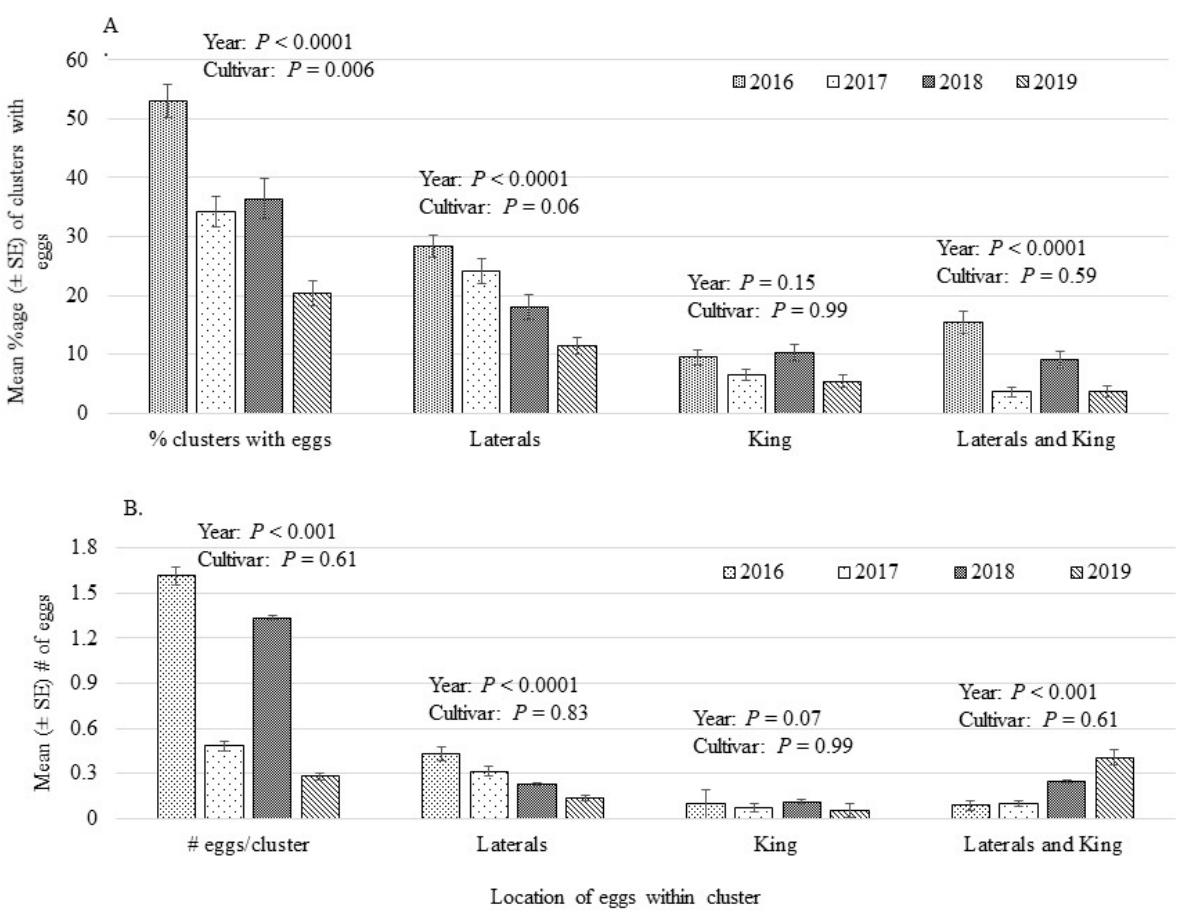
Figure 1. Within cluster location of eggs oviposited by Hoplocampa testudinea as ( A ) mean percentage of clusters and ( B ) mean number of eggs. Clusters taken from fifteen cultivars of apple with two blocks from 2016–2019, inclusive. Number of clusters examined each year: 2016—699, 2017—689, 2018—598, 2019—671. For A: F 2,79 values (Year) and F 14,79 (Cultivar) for % clusters with eggs: 12.72 and 2.44, Laterals: 7.36 and 1.73, King: 1.95 and 0.25, and Laterals and King: 17.25 and 0.87. For B: F 2.79 values (Year) and F 14.79 (Cultivar) for # eggs/cluster: 8.96 and 0.86, Laterals: 10.12 and 0.63, King: 2.64, 0.39 and Laterals and King: 8.87 and 0.86.